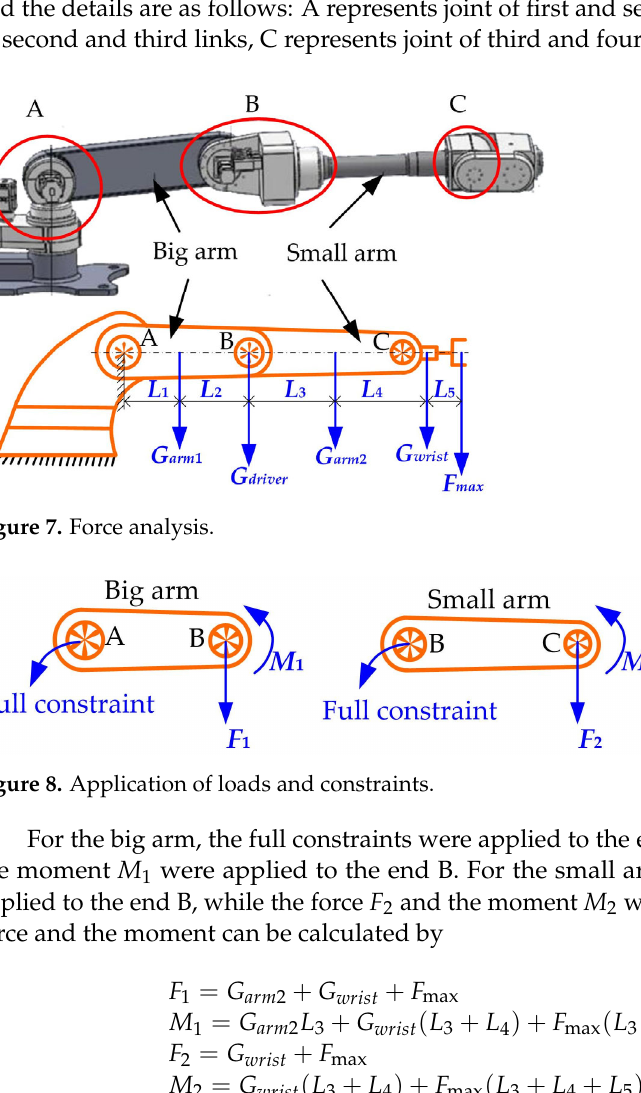
Figure 6. Finite element analysis model of the small arm.